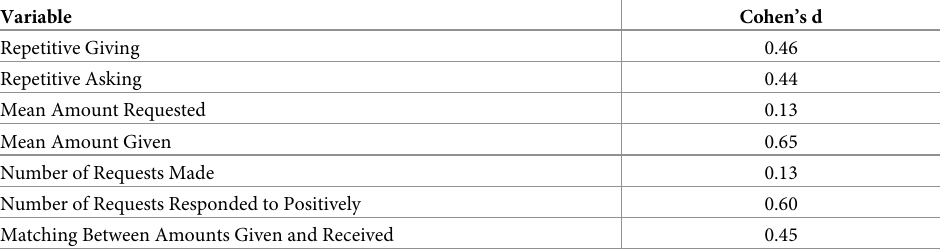
Table 3. Effect size estimates. Cohen’s d for our seven main variables as calculated by the Social Science Statistics (http://socscistatistics.com) web